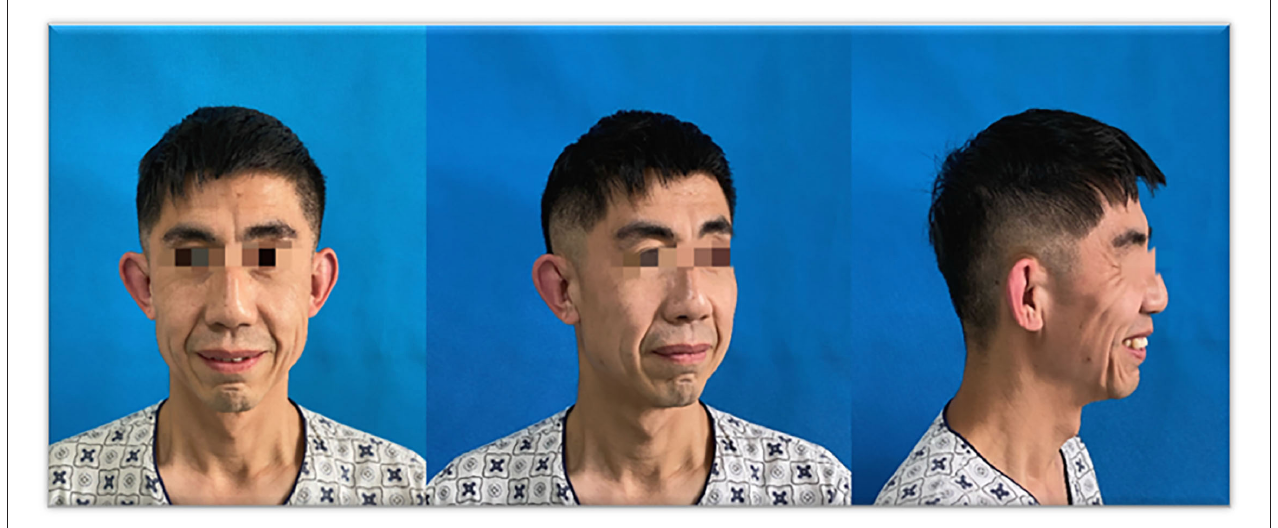
FIGURE 1 | Pre-operative frontal and oblique